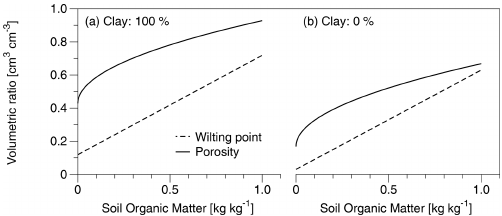
Figure B1. Simulations of wilting point, Eq. (11) improved from Park et al. (2019), and porosity, Eq. (12), proposed in this study, which are functions of soil organic matter in extreme case (a) vol- umetric clay mixing ratio 100% and (b) 0% of the total mineral within